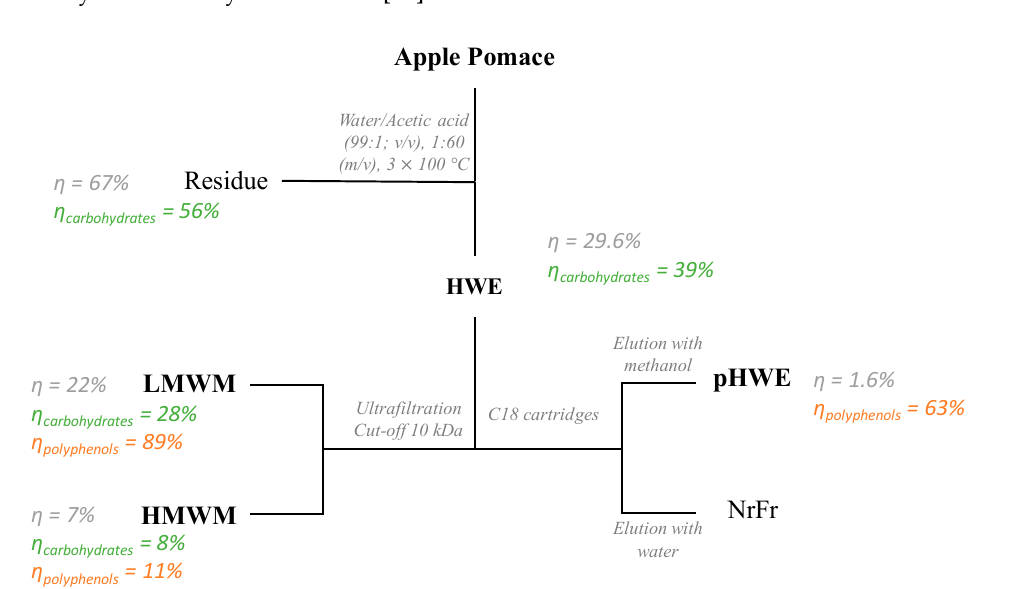
Figure 1. Schematic representation of the fractionation processes adopted in this work and yields of the extracts and polysaccharides in relation to apple pomace and polyphenols present in the hot water extract (dry basis). In bold are highlighted the fractions that were further studied. HWE—hot water extract; LMWM—low molecular weight material; HMWM—high molecular weight material; pHWE—purified hot water extract; NrFr—non-retained fraction.